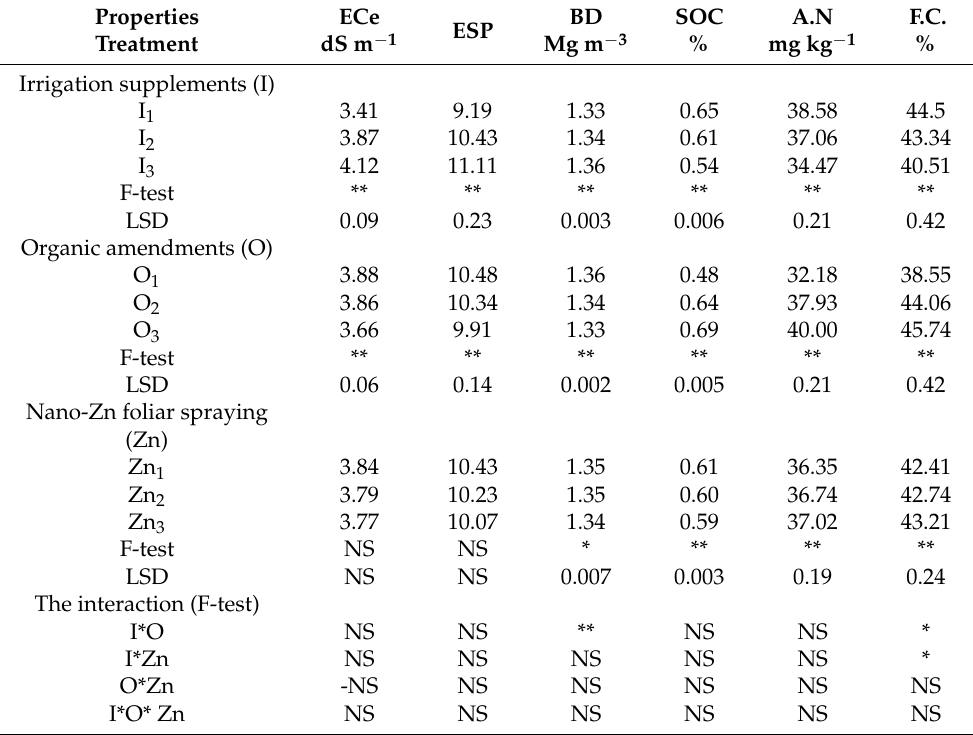
Table 6. Mean values of some physicochemical properties as affected by different organic amendments and foliar spraying applications under irrigation supplements for 2018/19 and 2019/20 seasons.